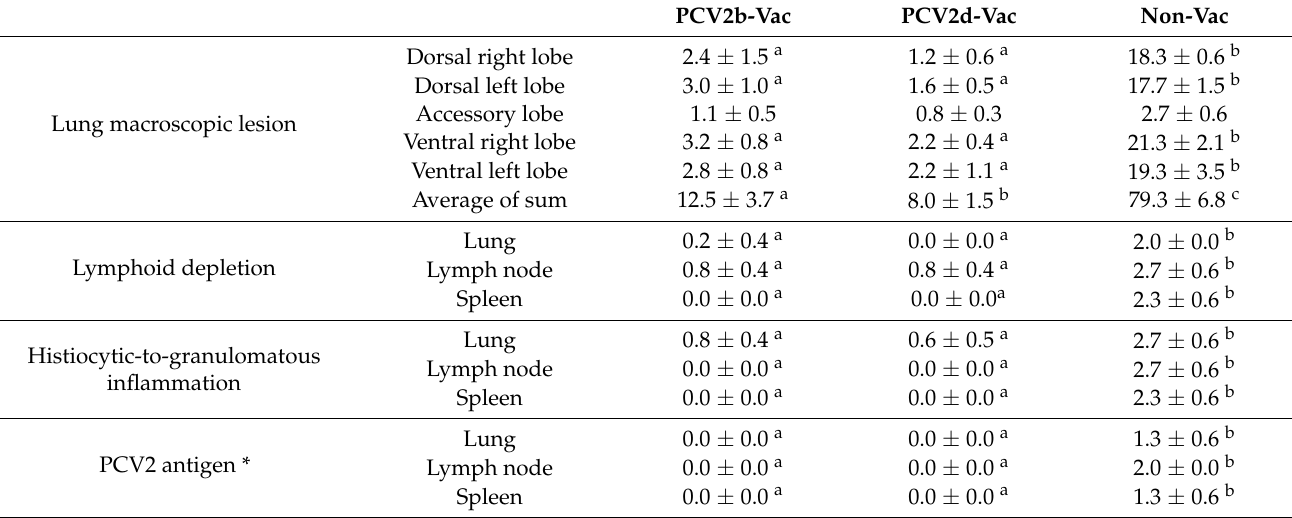
Table 3. Comparison of the macroscopic lung lesion score, lymphoid lesion score, histiocytic-to- granulomatous inflammation score, and PCV2 antigen score between the vaccinated and nonva- ccinated groups in the vaccine efficacy study (Experiment 2). All data are presented as group means ±